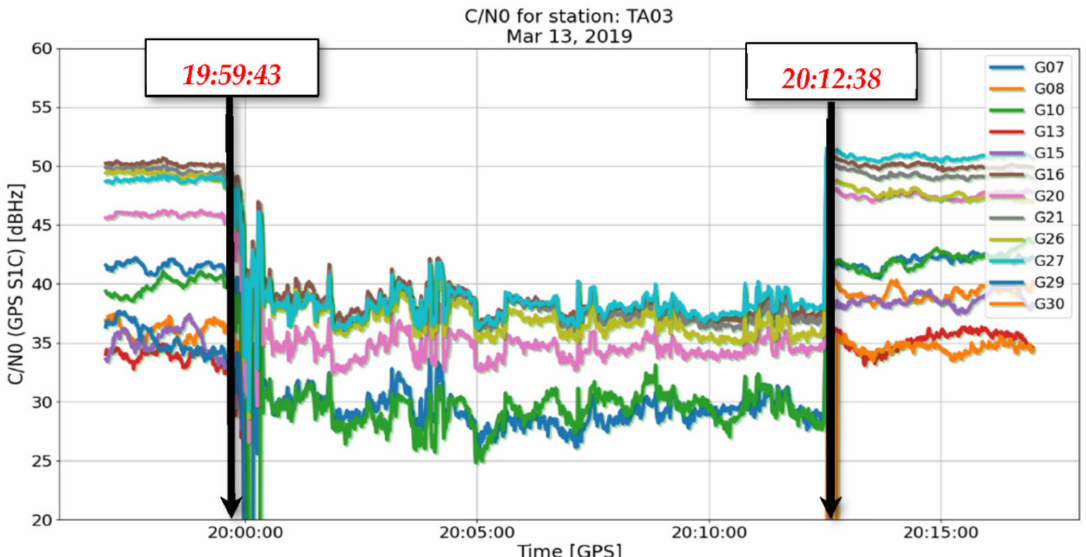
Figure 6. GPS L1 C/N 0 values for the Case 3 jamming incident; an approximately 12 min event affecting only the L1 band.